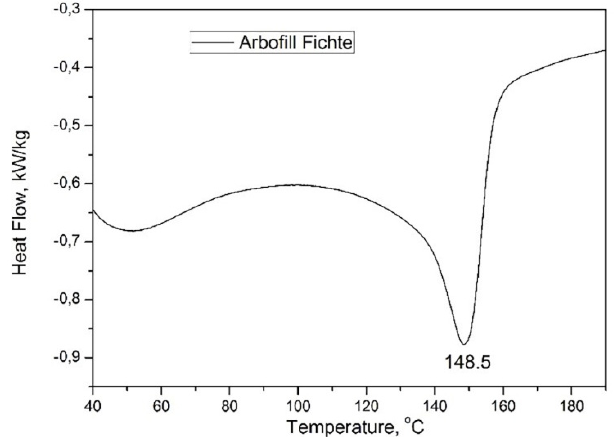
Figure 6. Highlighting the main thermal behavior of the wire made from Arbofill Fichte.